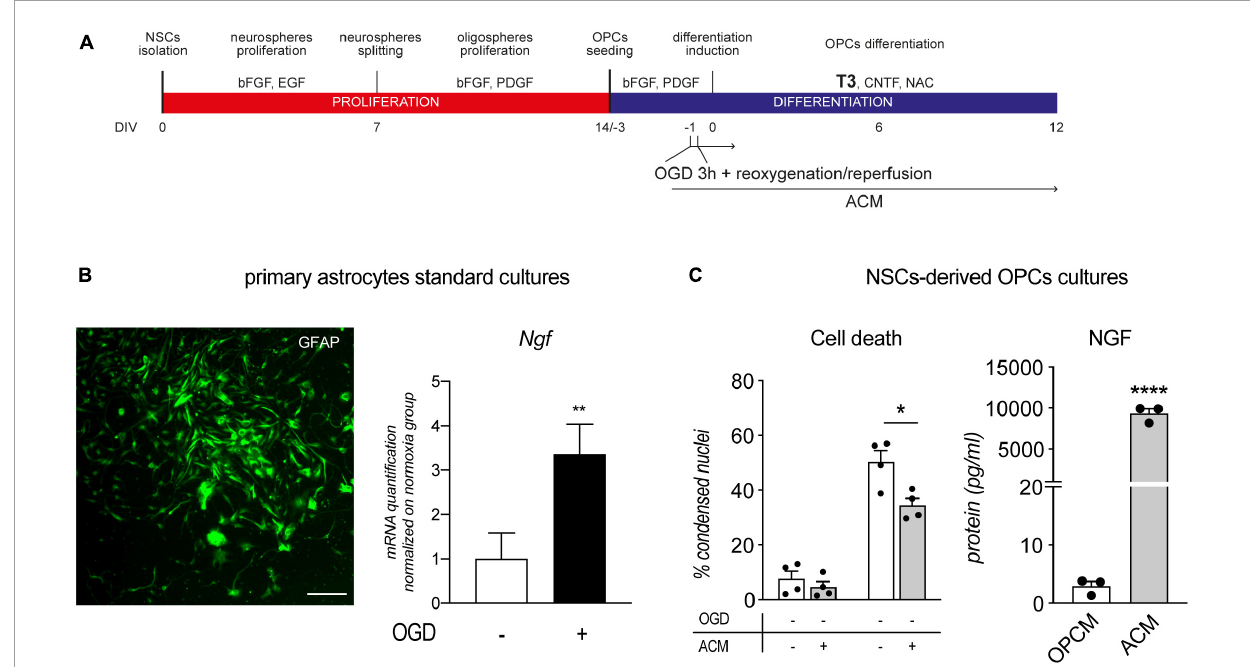
FIGURE5 Astrocytes conditioned medium protects OPCs from OGD. (A) NSC-derived mixed OPC/astrocyte cultures were exposed to OGD 24 h prior to T3-mediated differentiation induction (–1 DIV) and from 1 h before OGD exposure, to ACM. (B) Representative picture of GFAP stained primary astrocytes culture and RNA quantification of NGF gene expression following 3 h of OGD and 24 h of reoxygenation/reperfusion, in culture exposed and unexposed to OGD and normalized on normoxia-exposed groups ( n = 3 for both groups). Scale bar: 100 µ M. (C) Graphs show the percentage of condensed nuclei in cultures exposed to normoxia or OGD and treated or not with ACM, at the end of the differentiation phase (12 DIV), n = 4 for all the presented groups; and the quantification of NGF protein in oligodendrocyte precursor cell medium (OPCM) and astrocyte conditioned medium (ACM), n = 3. Bars represent mean ± SEM and single dots in the graph represent single independent experiments analyzed by high content screening (panel C , cell death) or single protein quantification from independent well (panel C , NGF). Statistical analysis: Student’s t -test ( Ngf gene expression, panel B ; NGF protein quantification, panel C ); Two-way ANOVA followed by Sidak’s post-test (Cell death, panel C ). Asterisk represents the difference between indicated groups (* p < 0.05; ** p < 0.01; **** p < 0.0001). ACM, astrocytes conditioned medium; bFGF, basic fibroblast growth factor; DIV, day in vitro ; EGF, epidermal growth factor; MBP, myelin basic protein; NG2, chondroitin sulphate proteoglycan, neural/glial antigen 2; NGF, nerve growth factor; NSC, neural stem cell; OGD, oxygen-glucose deprivation; OPCM, oligodendrocyte precursor cell medium; PDGF, platelet derived growth factor; T3,